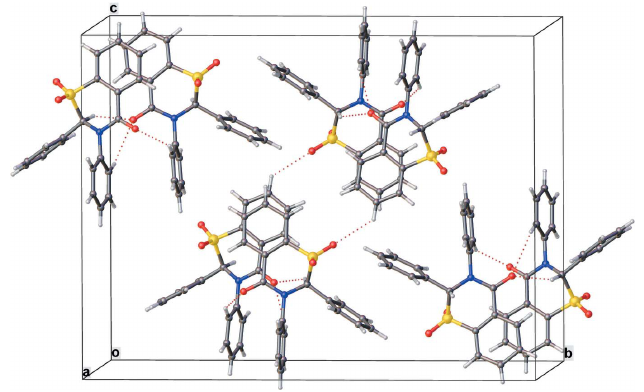
Figure 4 Crystal packing diagram for 1 showing intermolecular pairs of C—H (cid:2)(cid:2)(cid:2) O hydrogen bonds. Columns (four per unit cell) of molecules with alternating chirality, due to the translational periodicity down the a direction can be envisioned.